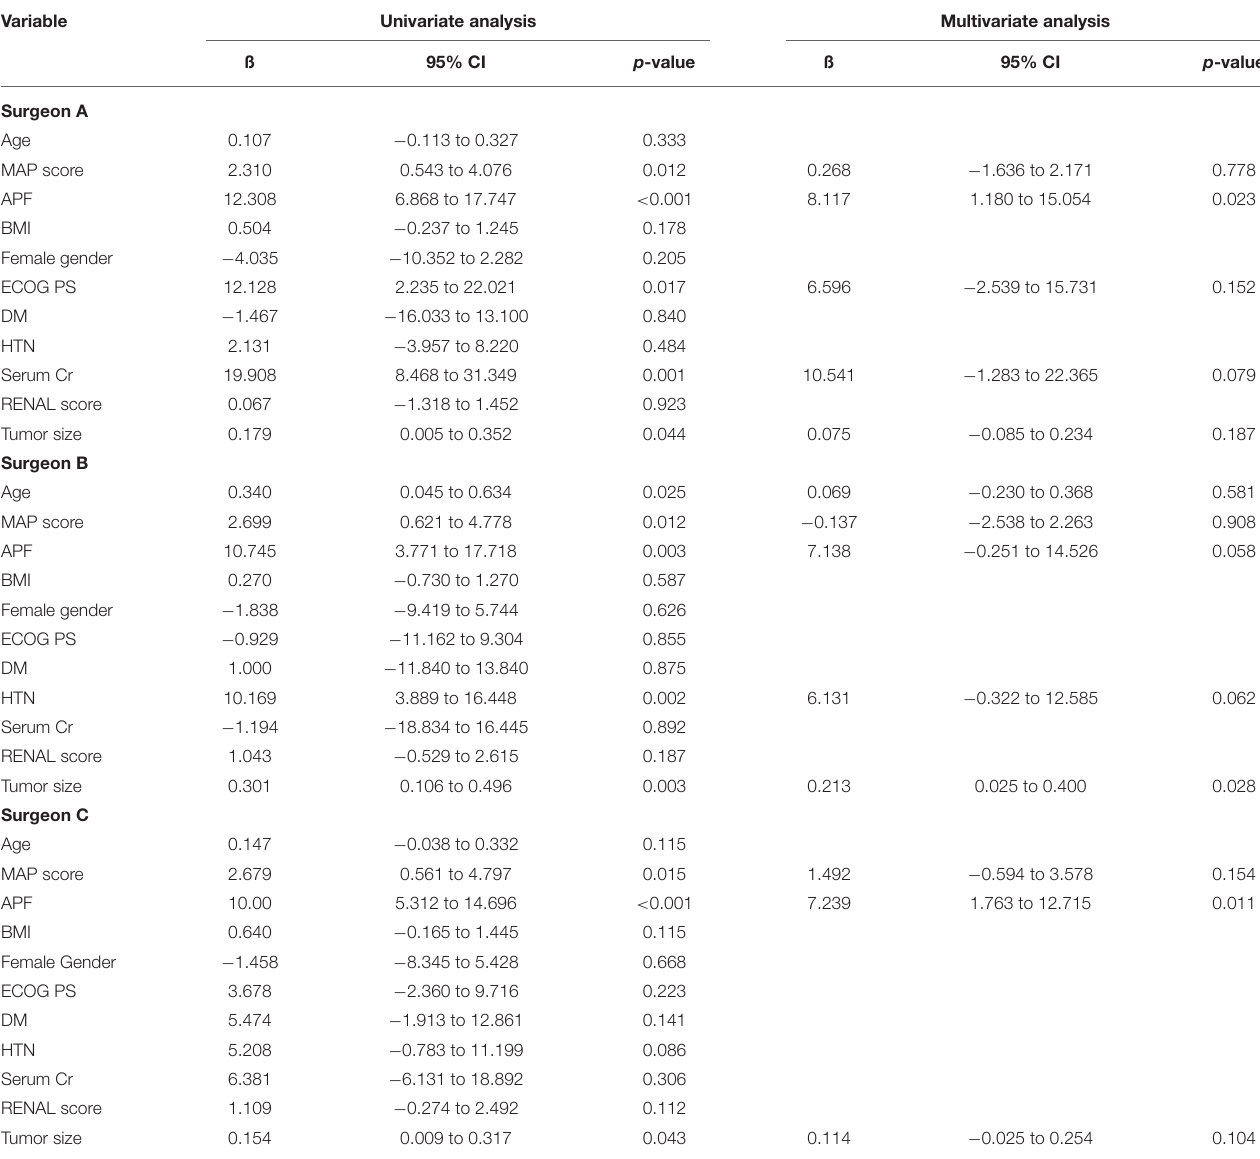
TABLE 3 | Linear regression analysis in each surgeon subgroup for evaluating factors associated with prolongation of the perirenal fat dissection time.